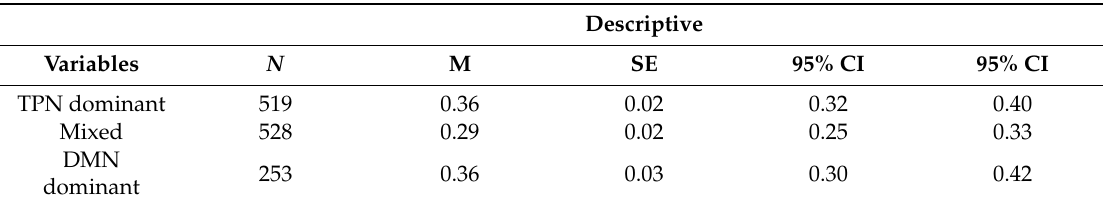
Table 5. Descriptive statistics of total noun-cues recalled across all trials (in proportion) as a factor of resting state network